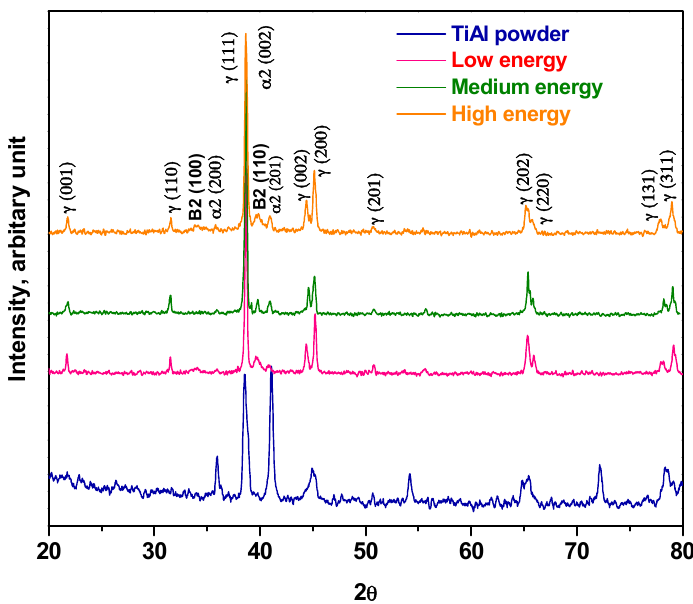
Figure 8. X-ray diffractograms of γ -TiAl samples produced using different energy inputs and feedstock powder.